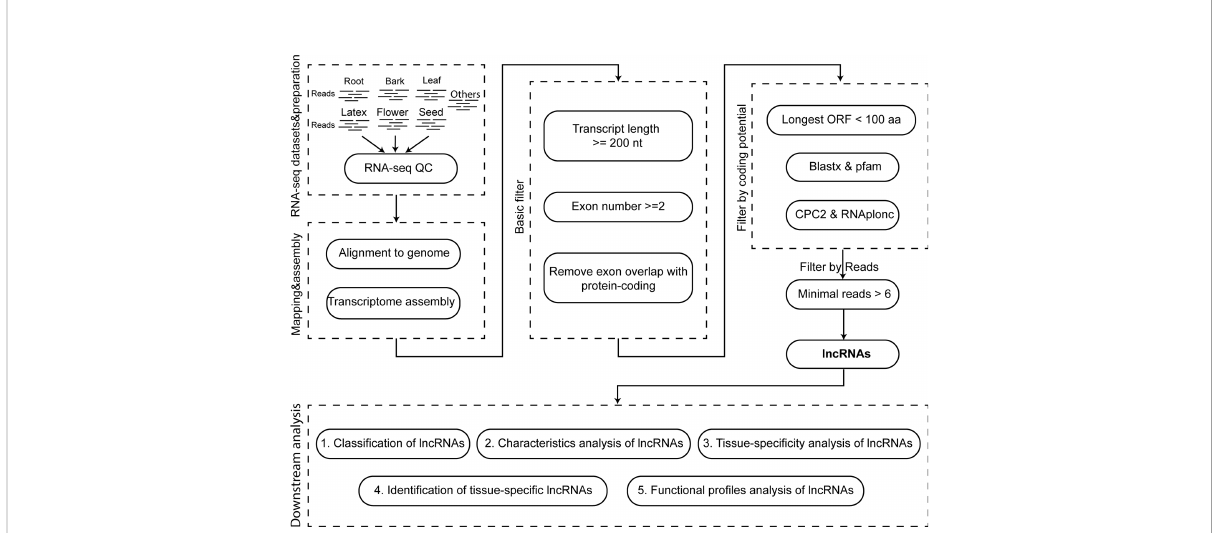
FIGURE 1 The fl ow chart for the identi fi cation and analysis of the long non-coding RNA. The fi rst box indicates the RNA datasets and their quality control. The second box represents the read mapping and assemble. The third and fourth box indicate the processes for the identi fi cation and screen of the lncRNA. The fi fth box is the downstream analysis of